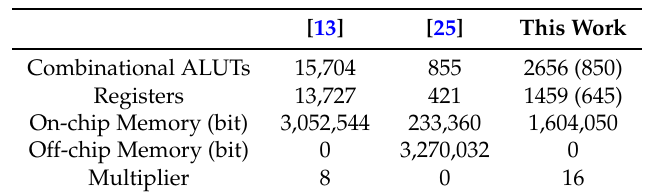
Table 3. Comparison of hardware-resource usage to previous straight-line detection systems using the Hough